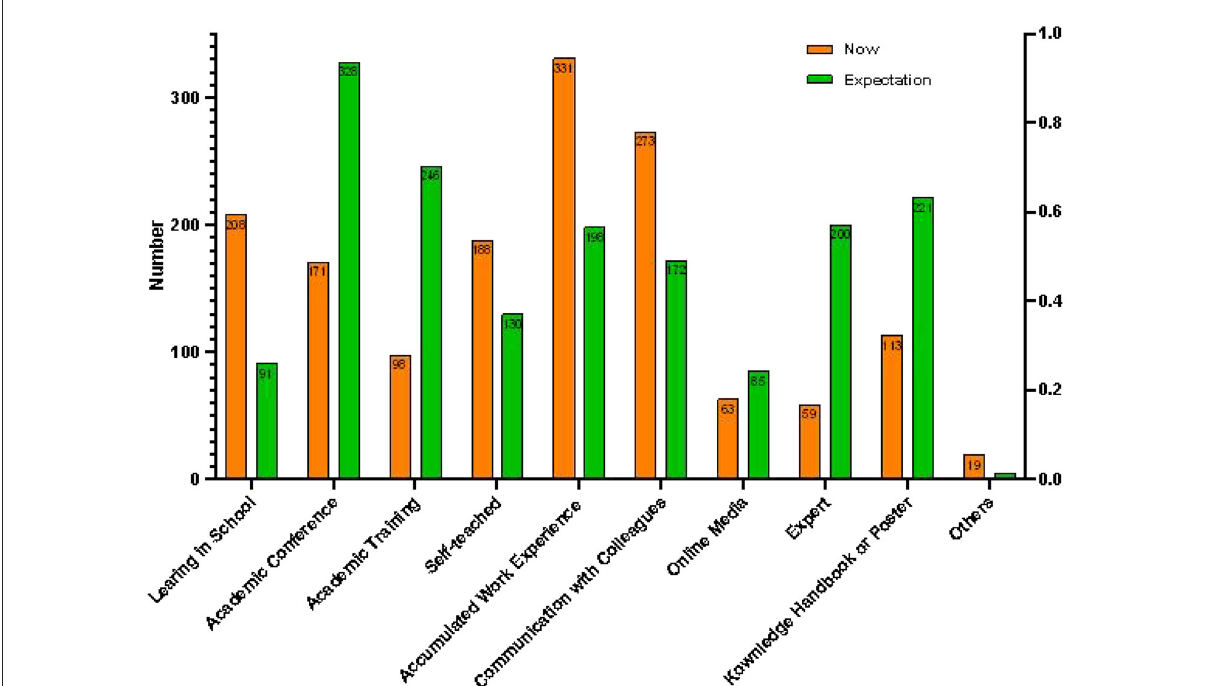
FIGURE2 Primary knowledge sources at present and the most desired in the future for clinical nurses.